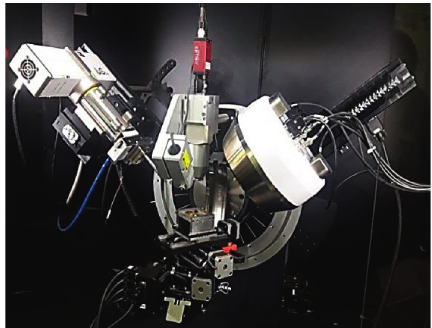
Figure 7: Bruker X-ray